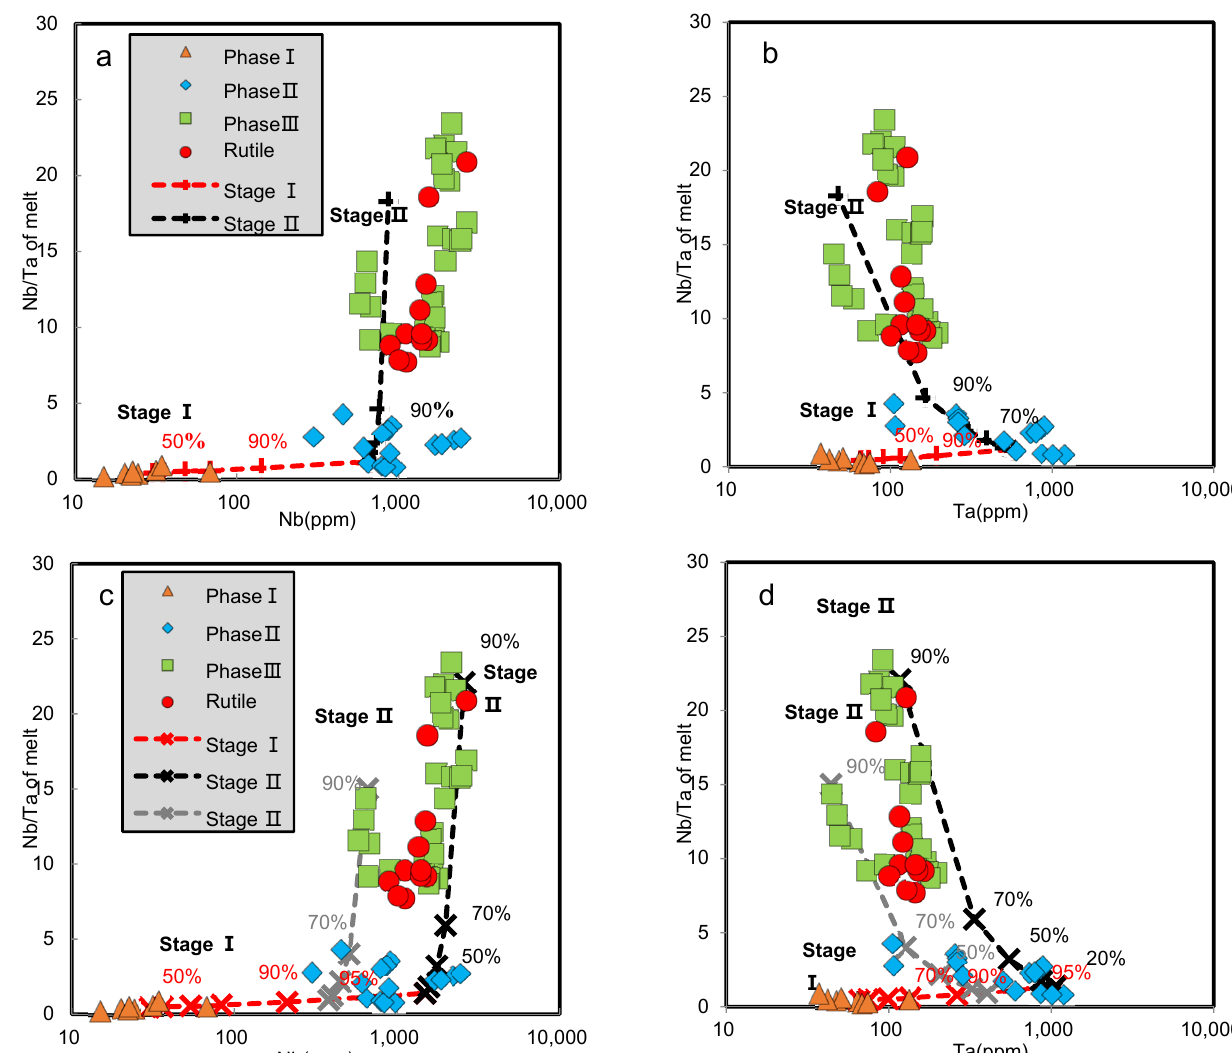
Figure 9. Nb/Ta ratio vs. Nb ( a,c ) and Ta ( b,d ) abundances for Phase I, III and III melts. Colored curves in ( a , b ) represent the evolution model of Nb and Ta during crystallization fractionation, assuming that the initial composition of the Stage I melt is Nb = 30ppm, Ta = 65ppm and Nb/Ta = 0.55, the proportion of rutile in Stage I crystallization assemblage is 1.2% and the proportion in Stage II is 3.5%. Colored curves in ( c , d ) assume that the initial composition of Stage I is the same as in ( a , b ), the proportion of titanite in Stage I is 2% and in Stage II is 10%. The influence of pyroxene, feldspar and quartz crystallization on the Nb/Ta ratio was not considered because of low D Nb and D Ta . Amphiboles were also not considered because of a low distribution in FGP. In addition, NYF-type pegmatite is poor in water and it is impossible to crystallize a large amount of biotite and muscovite. The D Nb and D Ta of rutile and titanite are from Green [44], Prowatke and Klemme [45], respectively. Numbers close to curves represent the amount of fractional crystallization. Stages I and II in Figure 9 refer to the residual melt produced after fractional crystallization as an independent magma system to continue crystallization. The difference between Stage II in ( c , d ) is the amount of fractional crystallization in Stage I.